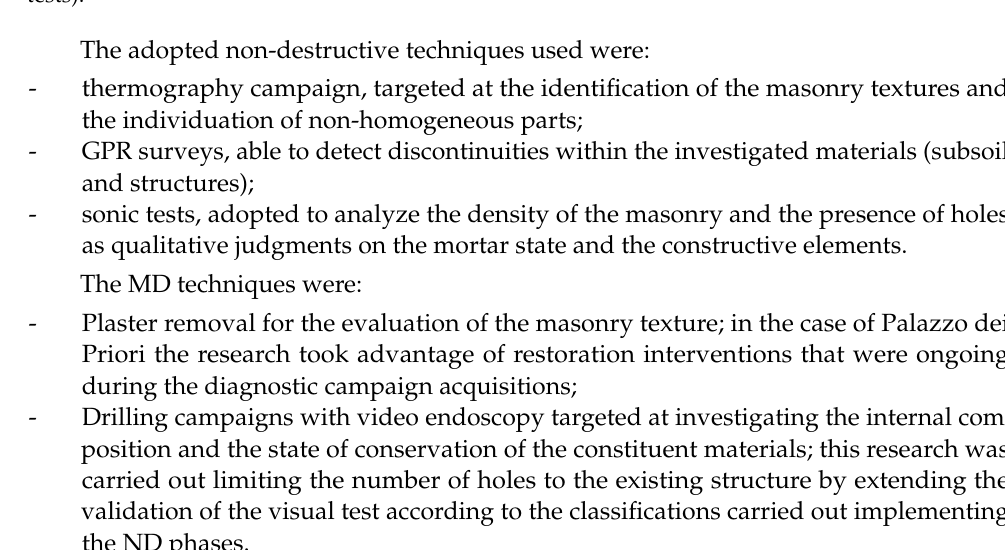
Figure 8. From the building to the BIM model: ND inspections (GPR, thermography, endoscopy tests).